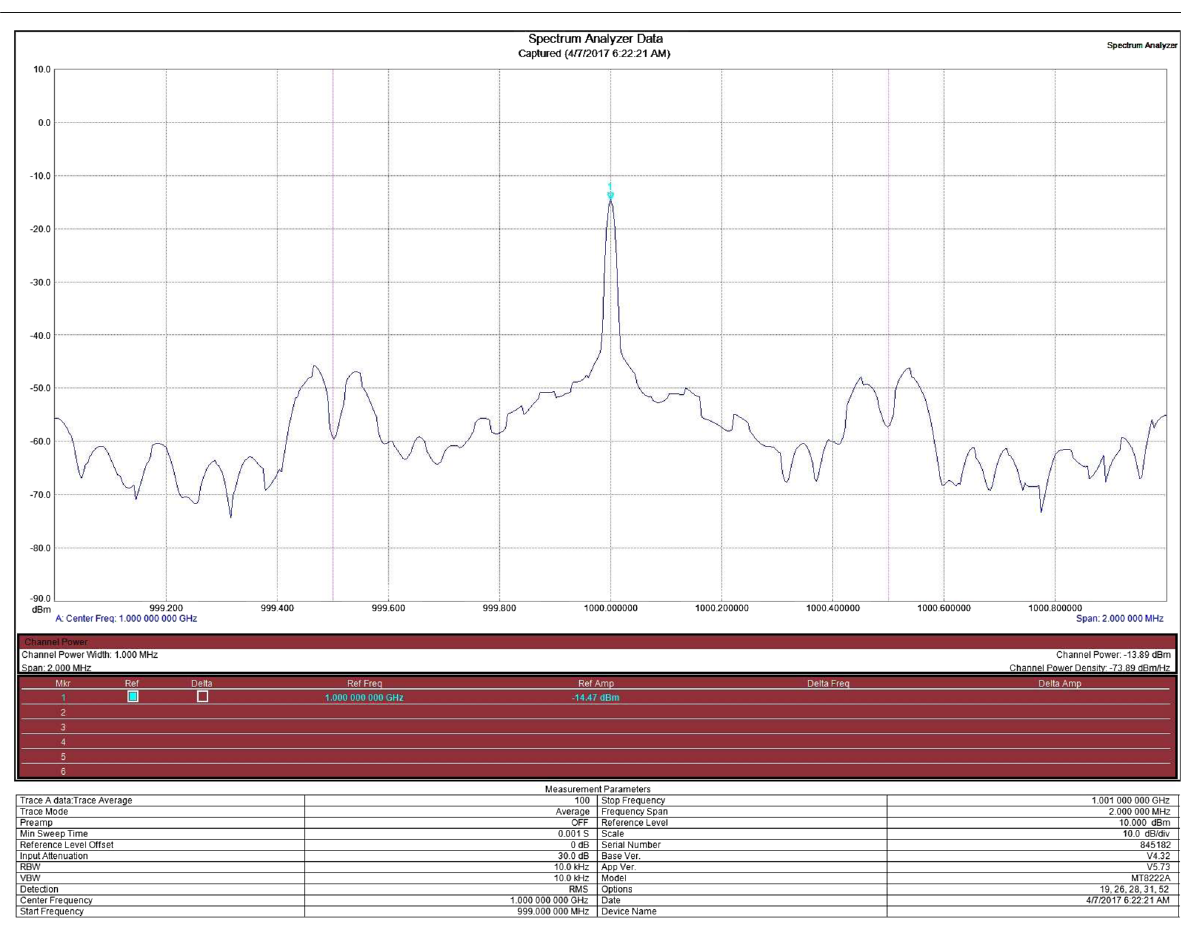
Fig. 11 Measurement of average channel power using spectrum analyzer for Duffing sequence